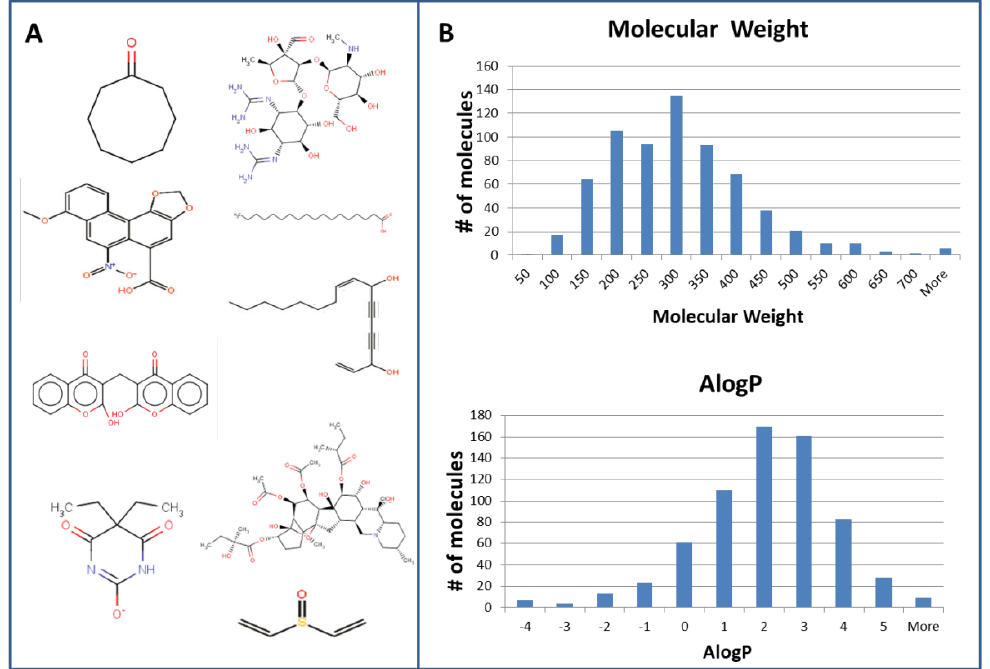
Figure 1. Bitter molecules are very diverse in their chemical structure and physicochemical properties. ( A ) Examples of molecules from variety of chemical families which were reported to elicit bitter taste; ( B ) Distribution of MW and AlogP values calculated for BitterDB molecules.